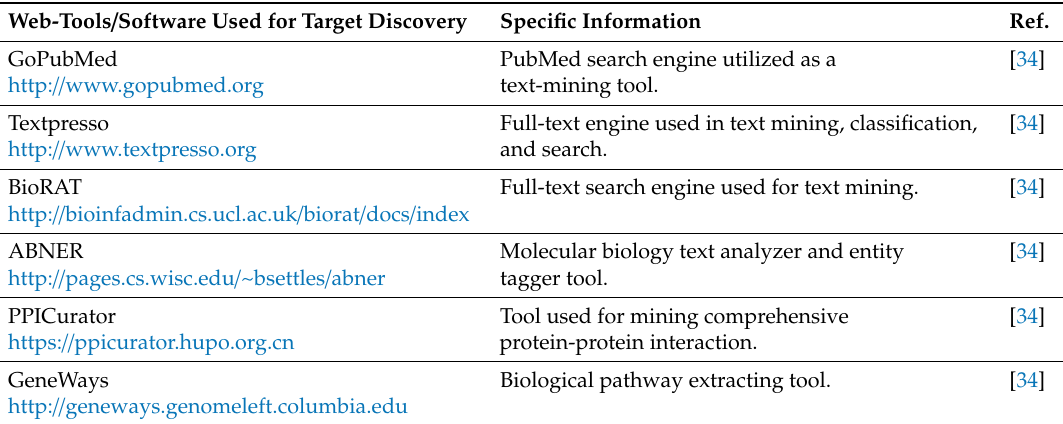
Table 2. Web-tools and software utilized in target discovery.